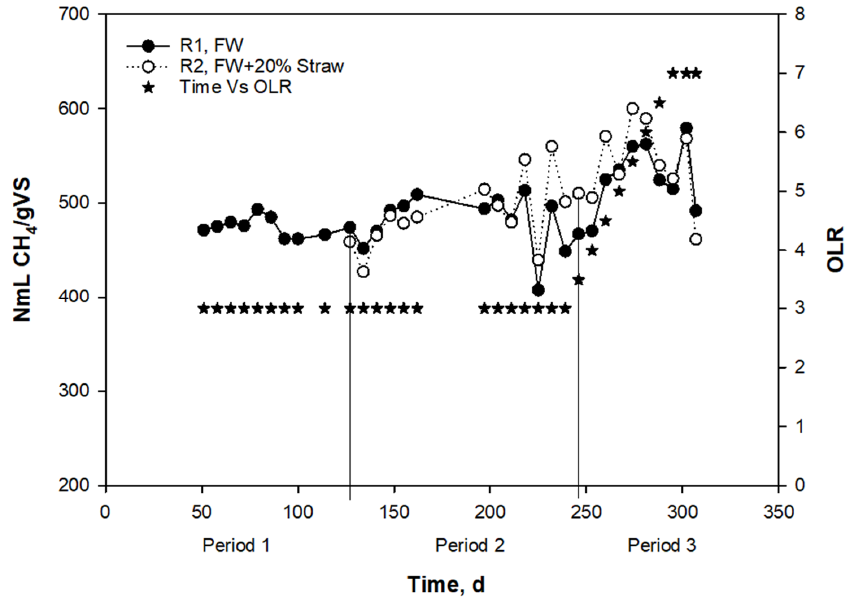
Figure 1. Specific methane production (SMP) obtained in R1 and R2 (target OLRs from FW were 3.0 gVS/L/d in Period 1 and Period 2 whereas 7.0 gVS/L/d in Period 3).